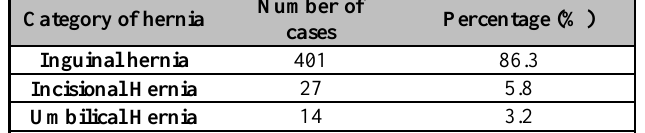
Table 1. Category of abdominal wall hernia Category of hernia